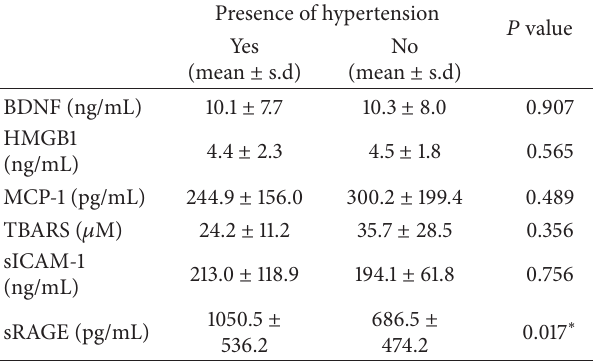
Table 4: Relationship between the serum levels of the studied factors and presence or absence of hypertension in patients with proliferative diabetic retinopathy.